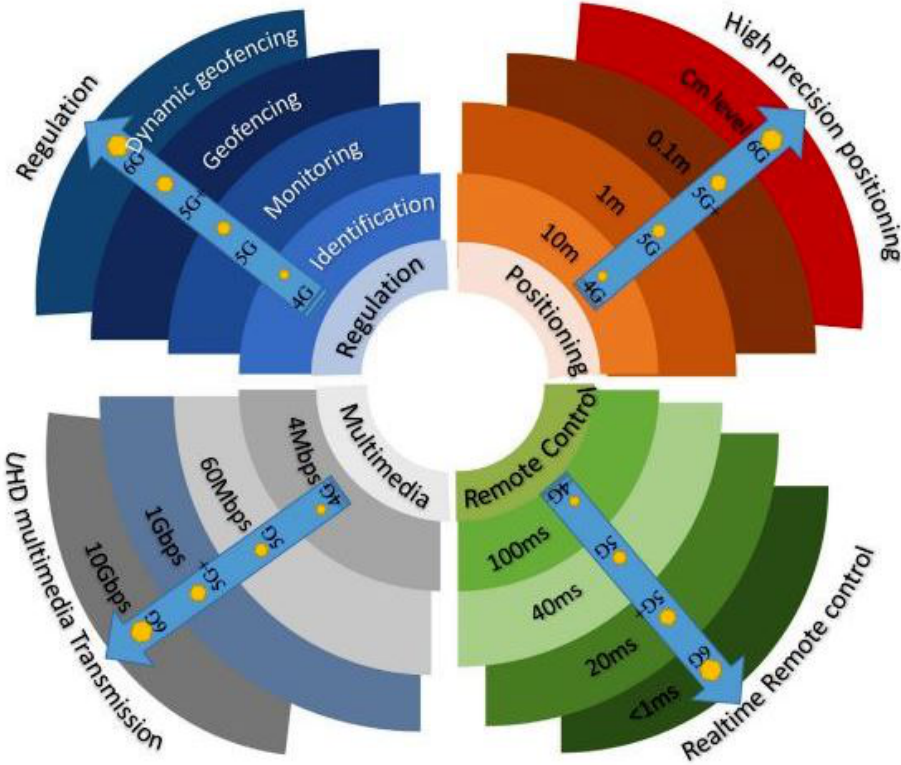
Figure 3. 6G technology for UAV